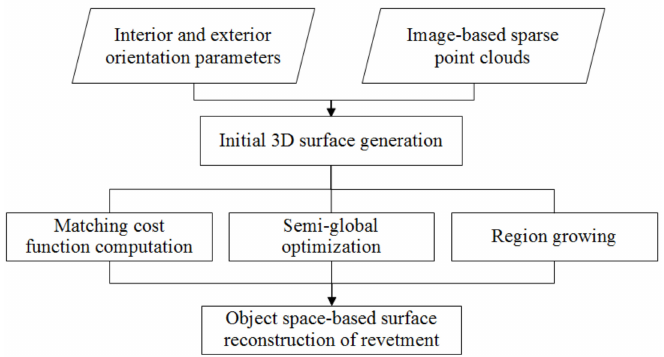
Figure 4. Object space-based surface reconstruction of